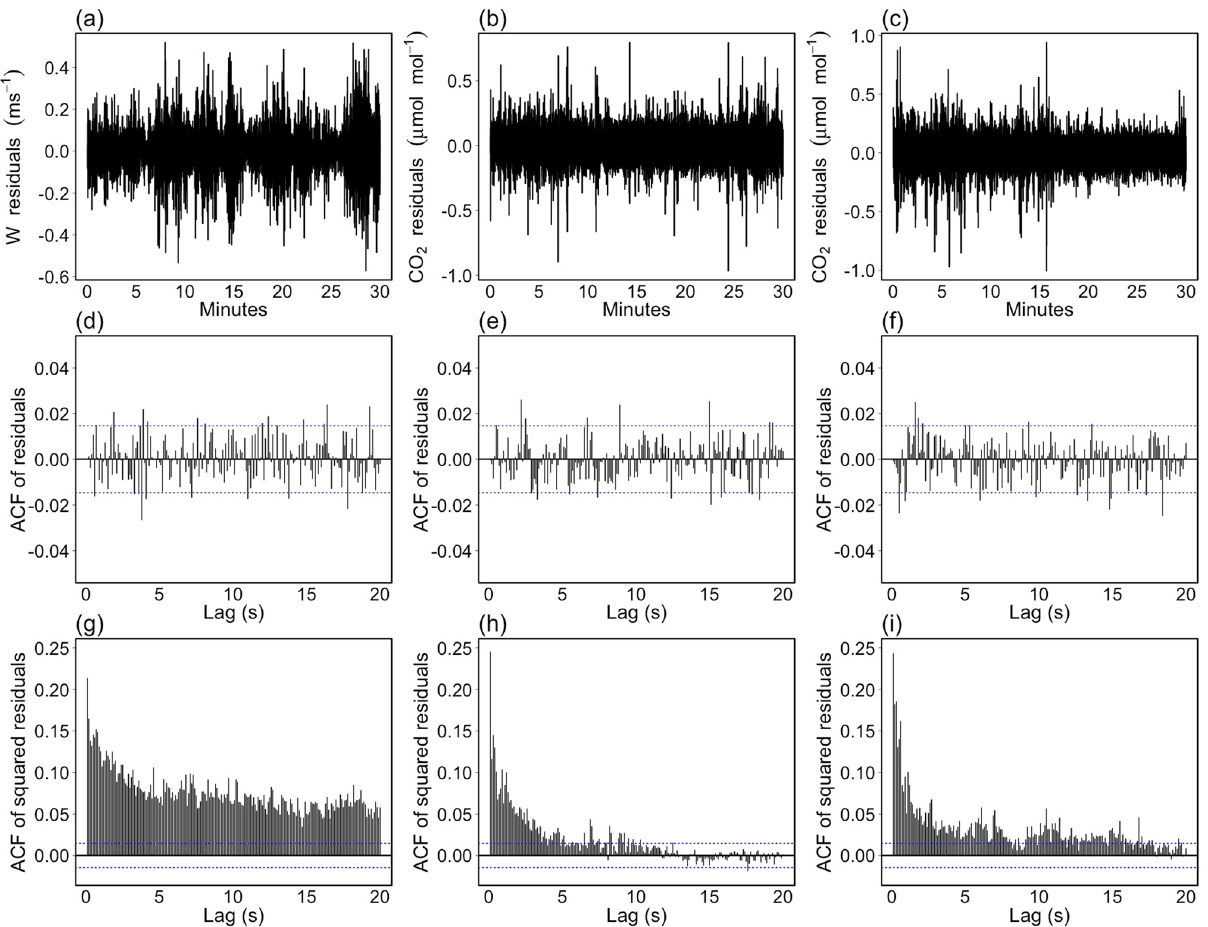
Figure 3. Diagnostic check of ARIMA models estimated on high-frequency time series depicted in Fig. 2. ( a – c ) Model residuals. ( d – f ) The corresponding autocorrelation functions (ACF). ( g – i ) The ACFs estimated on squared residuals. Dashed blue lines indicate the 95%